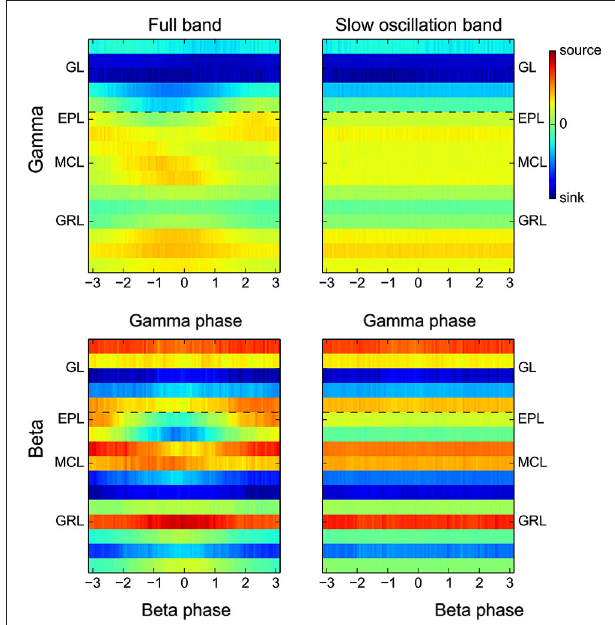
FIGURE 8 | Full band CSD during gamma or beta oscillations. Group CSD maps computed as in Figure 2B but either without prior filtering of the raw signal (full band, left panels) or with a filtering of the raw signal in the low frequency band only (0.1–10 Hz, right panels). The slow CSD modulation adds large and constant offsets, different for each electrode, to the fast CSD modulation. Right panels display only the offsets while left panels display the addition of slow and fast CSD modulations. Due to the additivity of the slow and fast CSD modulations, the difference between left and right panels is qualitatively equivalent to Figure 2B